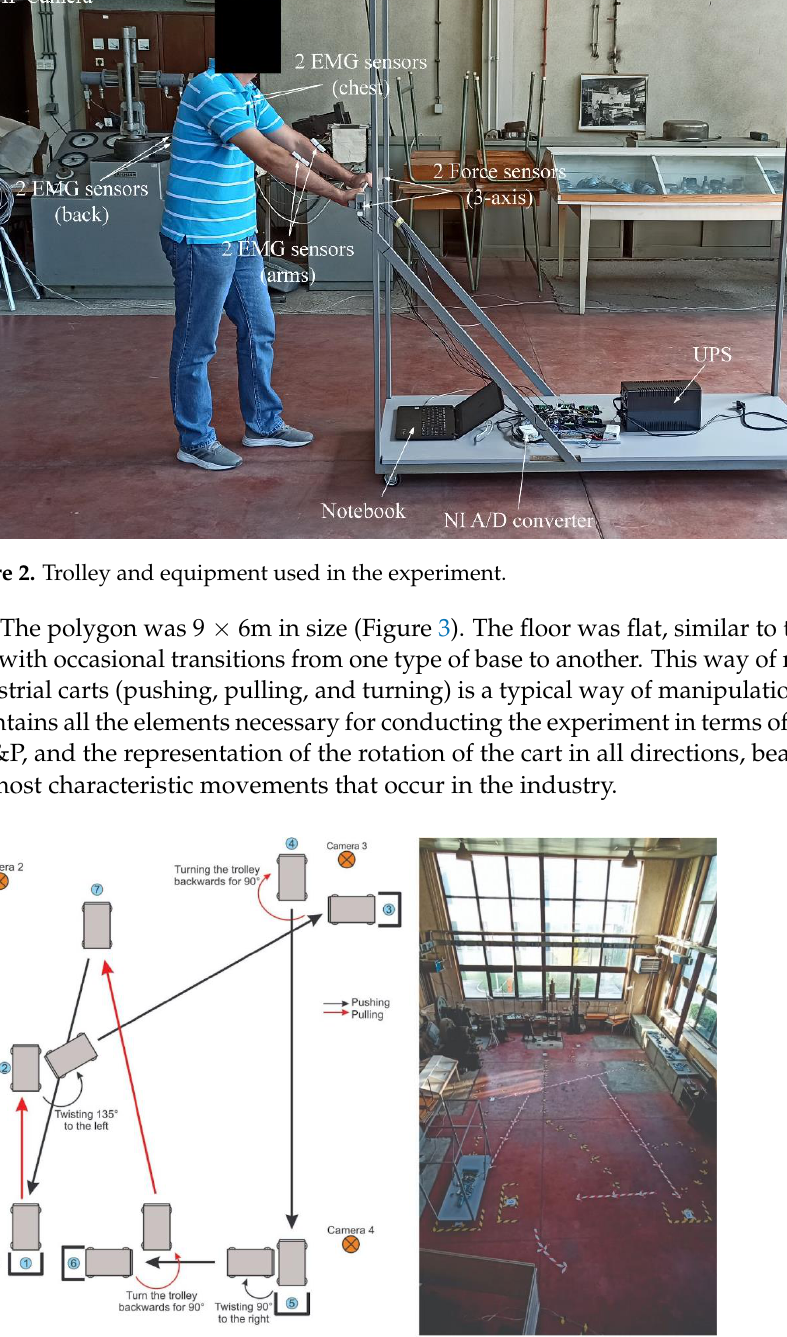
Figure 1. Flowchart of the experiment.